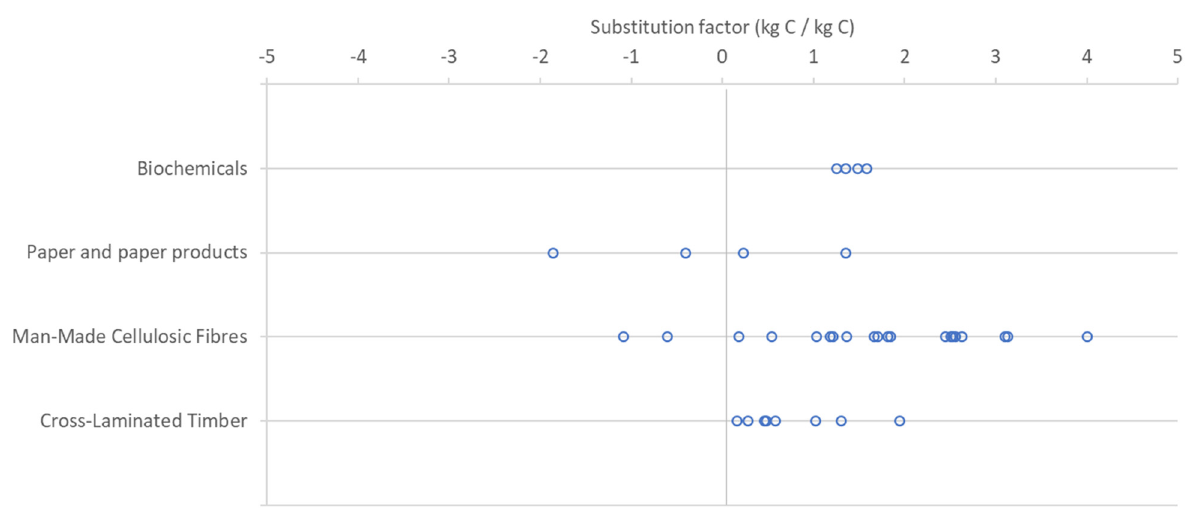
Figure 1. Overview of substitution factors reported in the literature for the selected product categories. See Table S1 (in Supplementary Materials) for details on the individual studies.